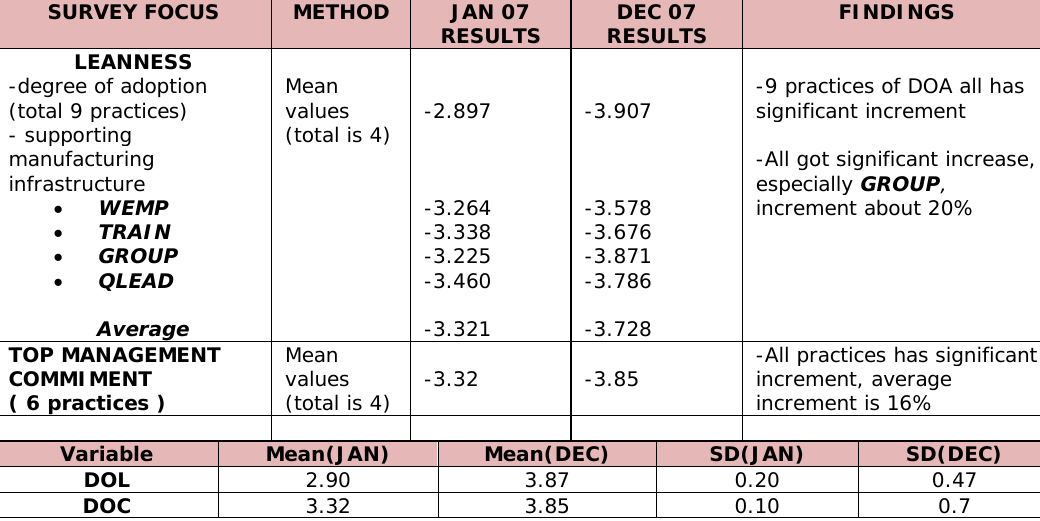
Table 3. “Mean values and standard deviation of DOL and